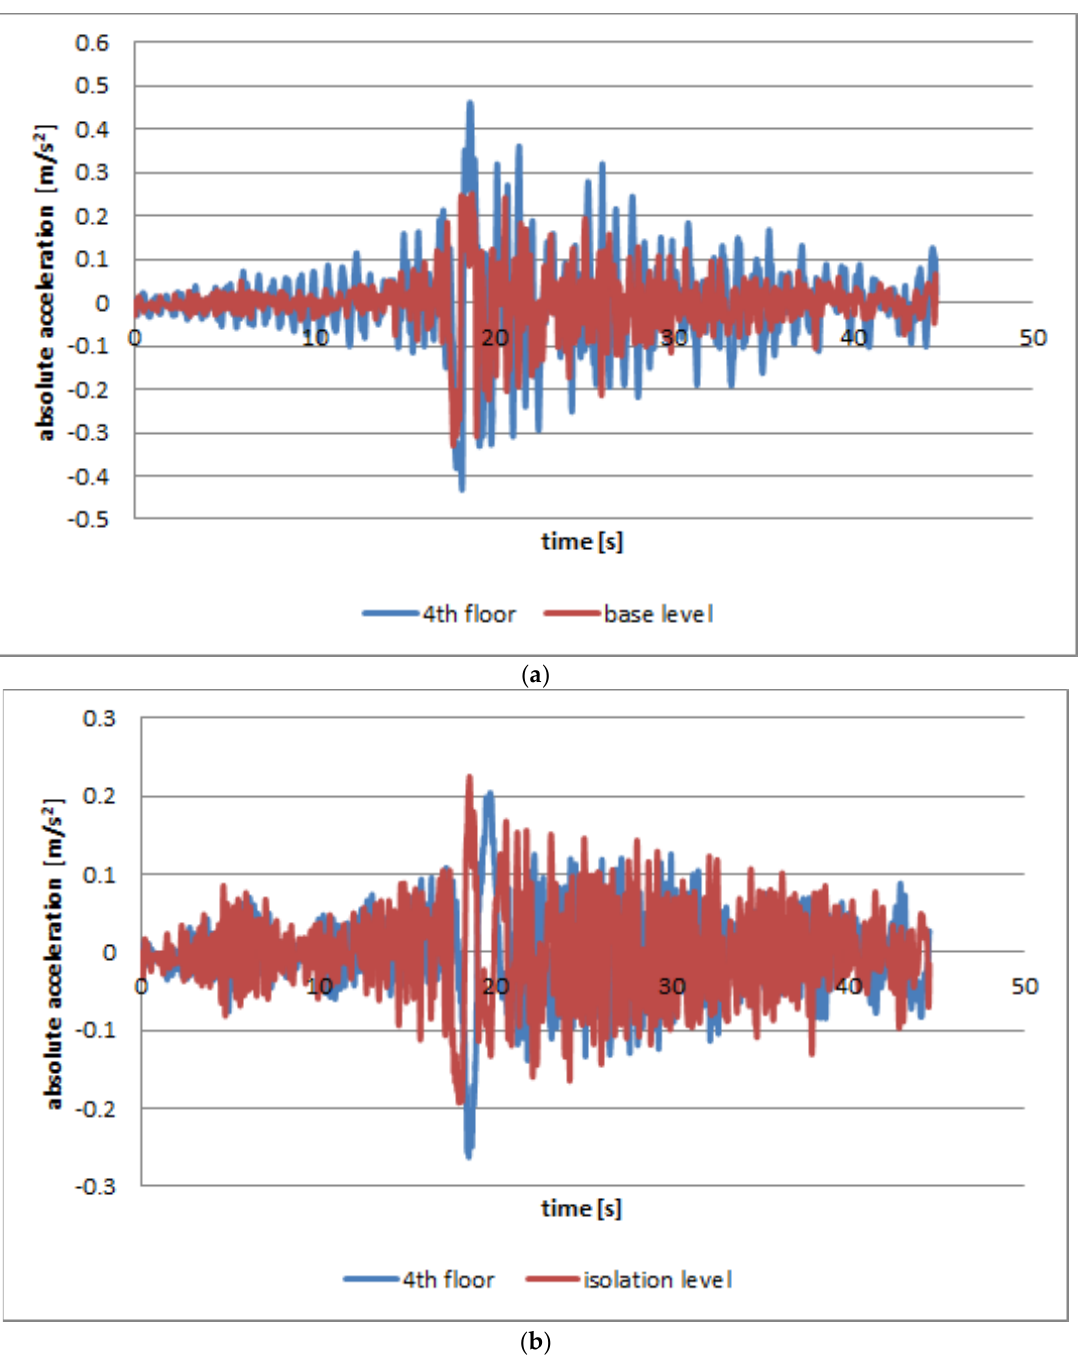
Figure 9. Absolute acceleration time histories, INCERC 1977 spectrum compatible ground acceleration record: ( a ) classic building; ( b ) base-isolated structure.